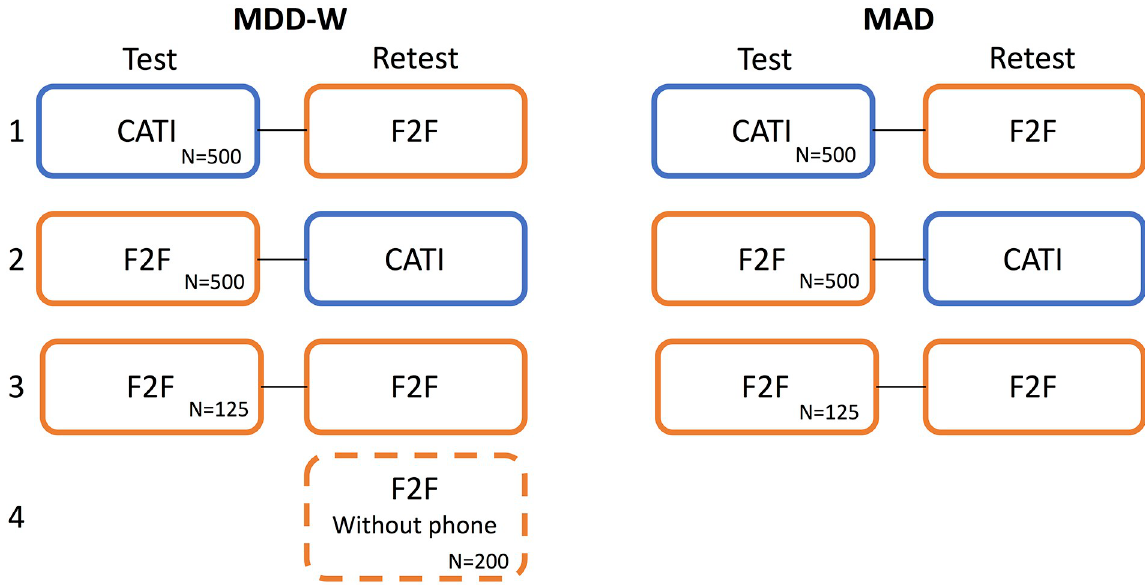
Fig 1. Experimental design. Test-retest mode experiment on two nutrition indicators, MDD-W and MAD. Survey consisted of four treatment arms: two main treatment arms testing for mode differences, arm 3 controlling for temporal effects and arm 4 controlling for non-coverage bias. Target sample sizes are